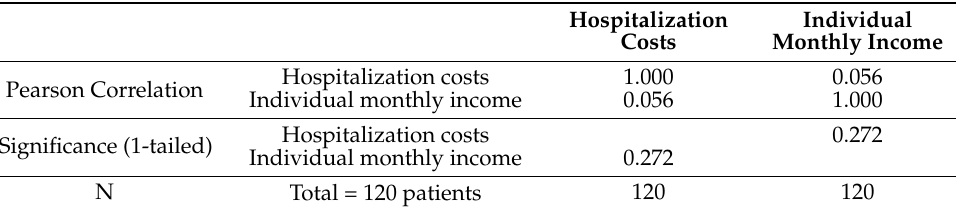
Table 6. Correlation between individual income and hospitalization costs.